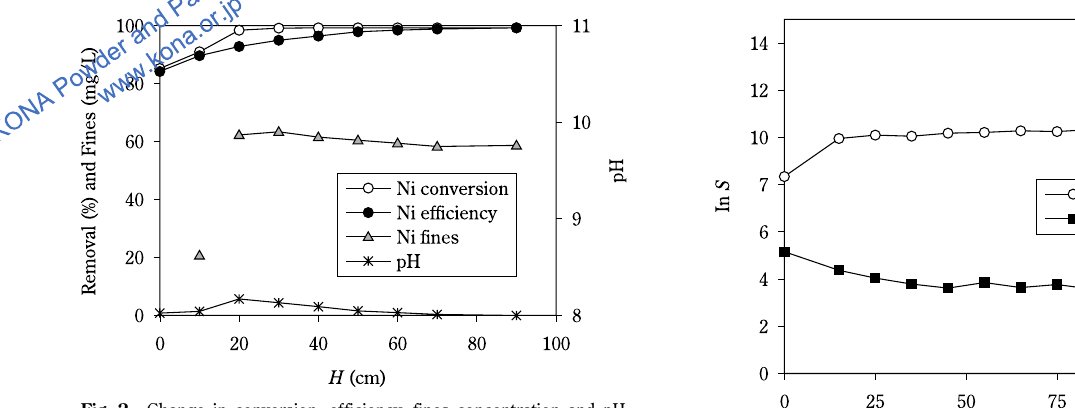
Fig. 2 Change in conversion, efficiency, fines concentration and pH with reactor height.